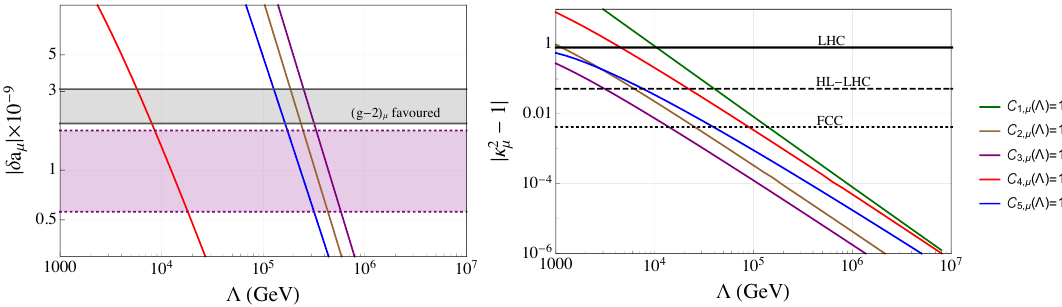
Figure 5 . Left : induced shift in the muon anomalous magnetic moment from δc 2 ,µ as function of the NP scale Λ . The horizontal gray and purple bands show the ( g − 2) µ favored region assuming δa µ as in eq. (4.2) or in eq. (4.3) respectively. Right : induced shift in Higgs to two muons decay from δc 1 ,µ as function of the NP scale Λ . The horizontal solid line shows present bounds from measurements at LHC, while dashed and dotted lines show projections from HL-LHC and FCC